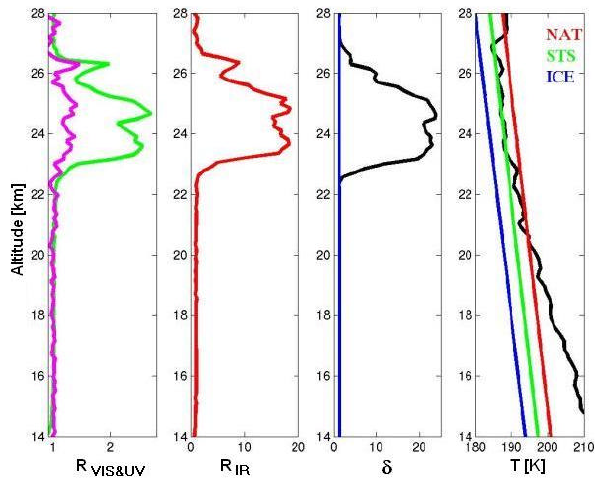
Fig. 8. LIDAR measurements from the Koldewey Station in Ny- ˚Alesund on 9 December 2002. The signals are time averaged from Figure 8. LIDAR measurements from the Koldewey Station in Ny-Ålesund on Dec. 9, 2002. 16:00–24:00 UT. R is the backscatter ratio as a function of alti- The signals are time averaged from 16-24 UT. R is the backscatter ratio as a function of tude and wavelength (532nm VIS (Green); 353nm UV (Indigo) altitude and wavelength (532 nm VIS (Green); 353 nm UV (Indigo) and 1064 nm IR (Red)). and 1064nm IR (Red)). δ is the Depolarization values. The de- d is the Depolarization values. The deduced temperature (Black line) is plotted together with duced temperature (black line) is plotted together with PSC thresh- PSC threshold temperatures for NAT (blue line), STS (green line) and ice (blue line). old temperatures for NAT (blue line), STS (green line) and ice (blue